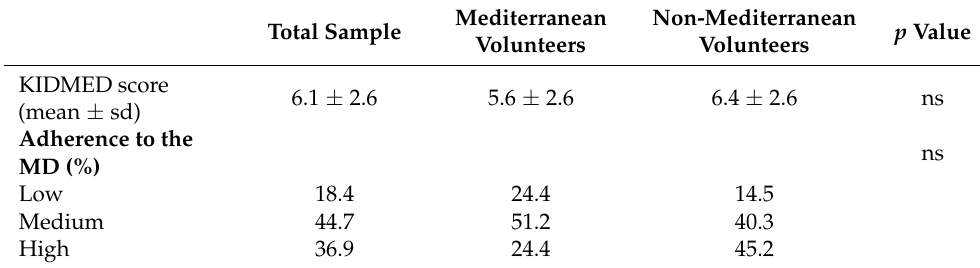
Table 8. Adherence to the MD by geographical area of